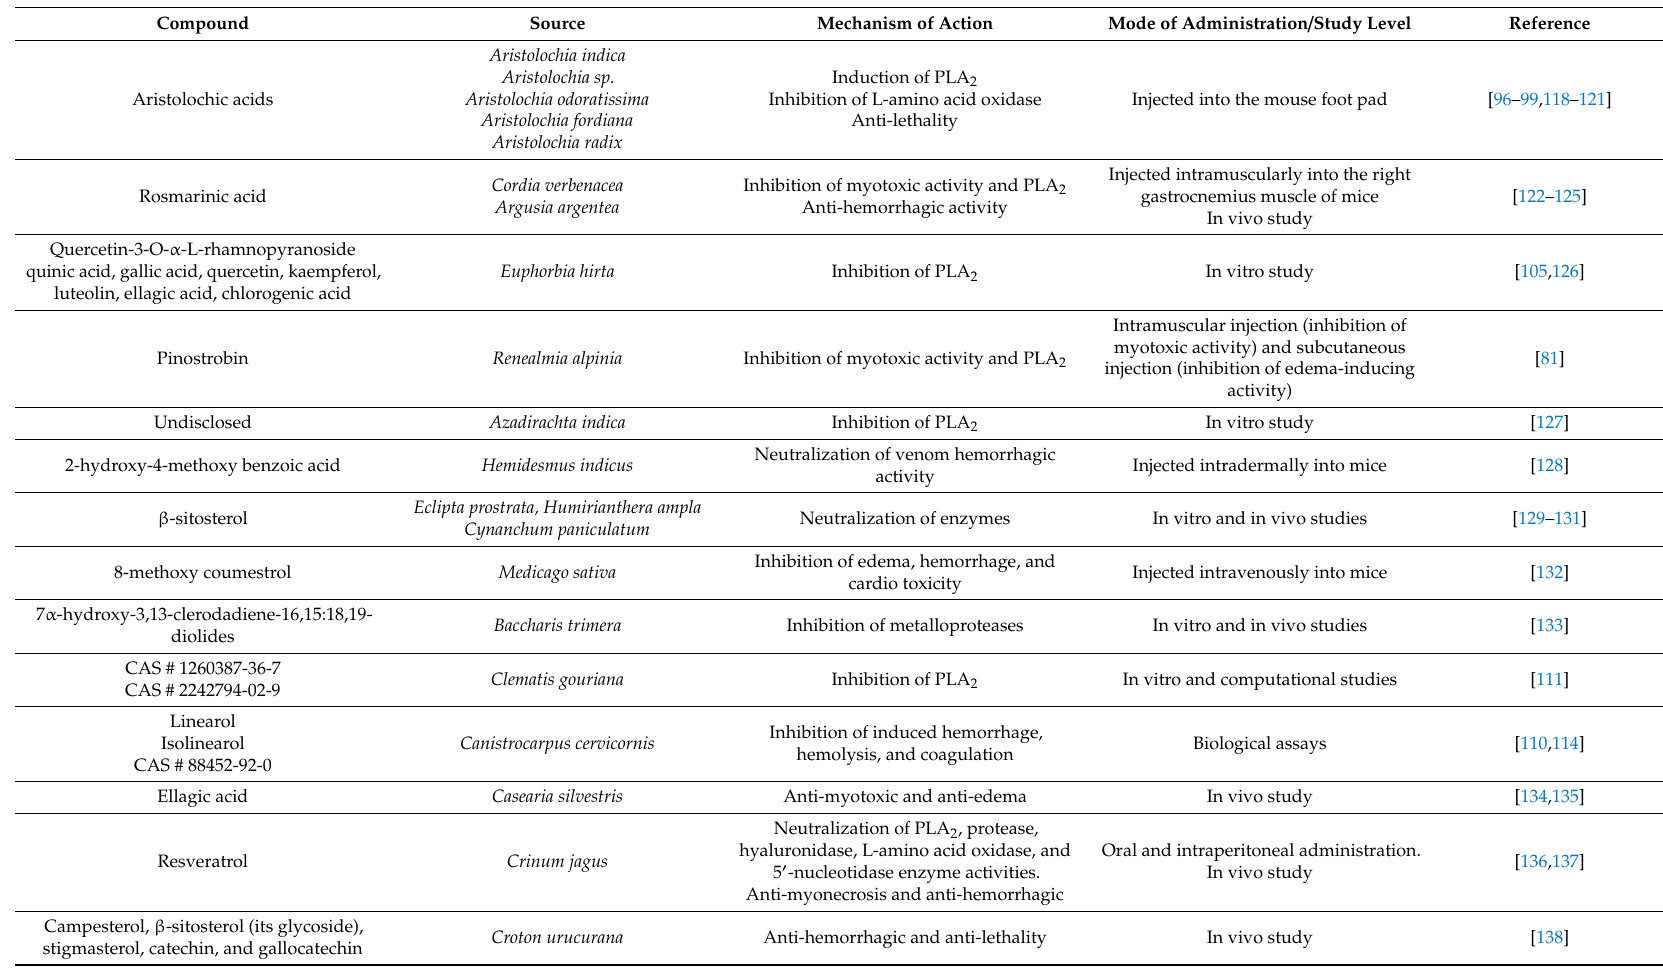
Table 2. List of isolated bioactive compounds with venom neutralization capabilities and their mechanisms of